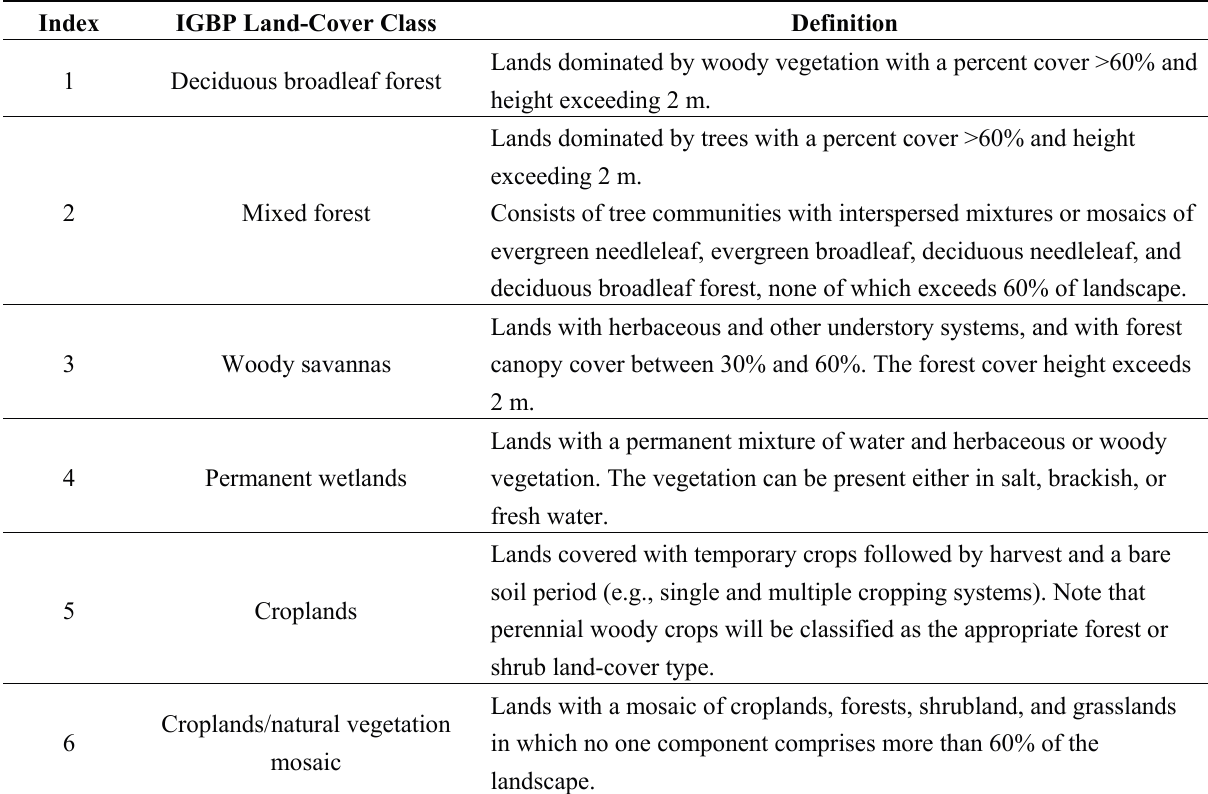
Table 1. IGBP (International Geosphere–Biosphere Program) land-cover classes and definitions (modified from